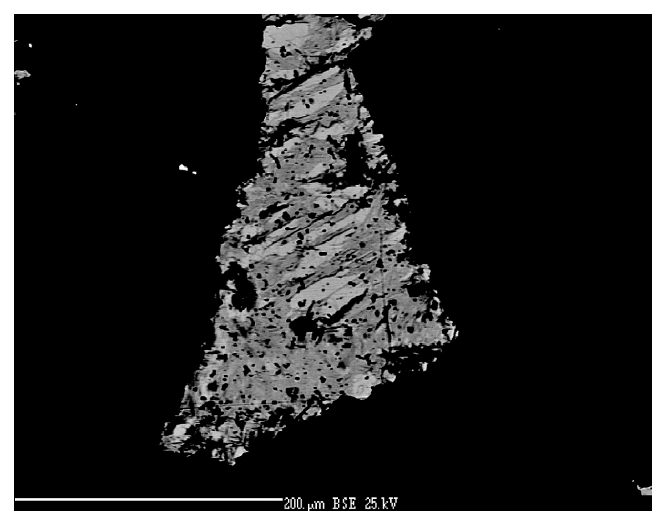
Figure 40. Inhomogeneous aggregates of Ag-Cu-Se phase close to eucairite with naumannite lamellae